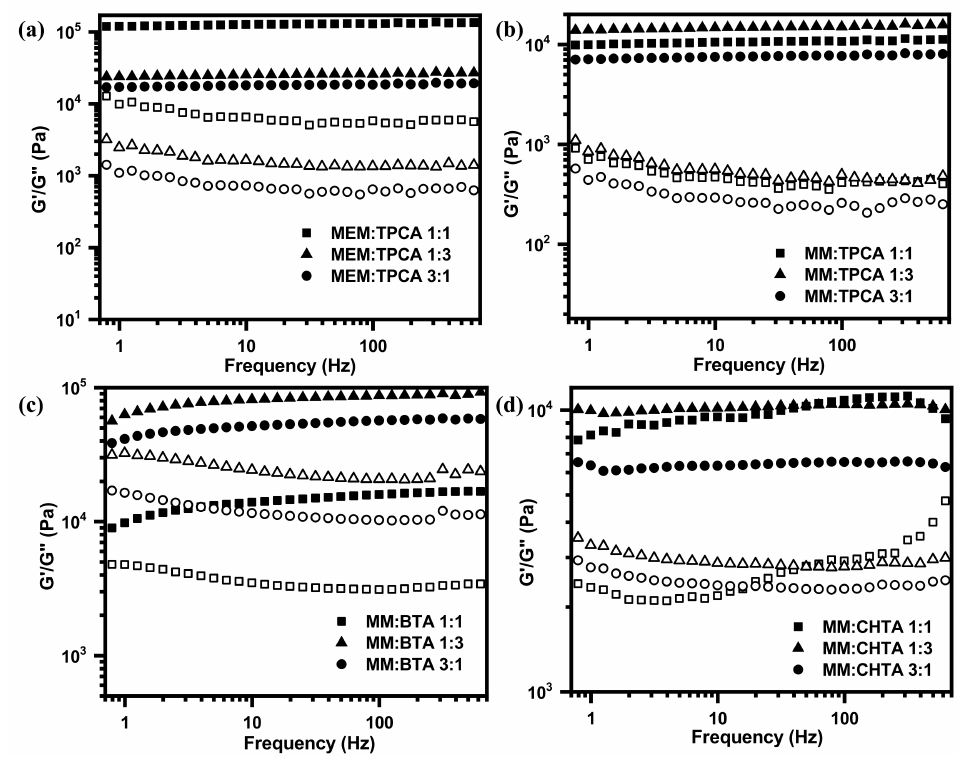
Figure 7. Frequency sweep of ( a ) MEM–TPCA, ( b ) MM–TPCA, ( c ) MM–BTA and ( d ) MM–CHTA hydrogel networks at three different molar ratios.